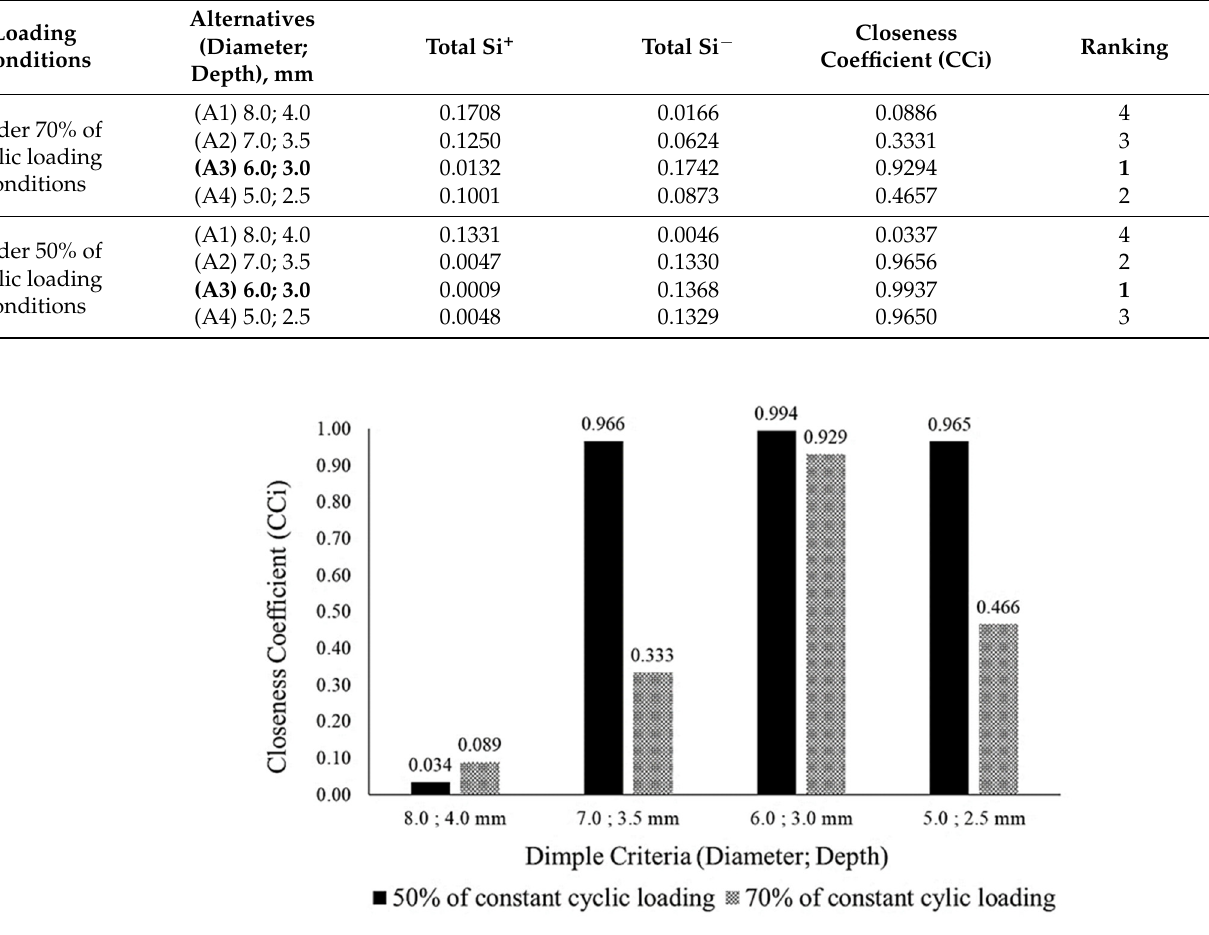
Figure 14. The ranking (read from highest to lowest value) between the dimple core design alterna- tives under cyclic loading conditions of 50% and 70%.